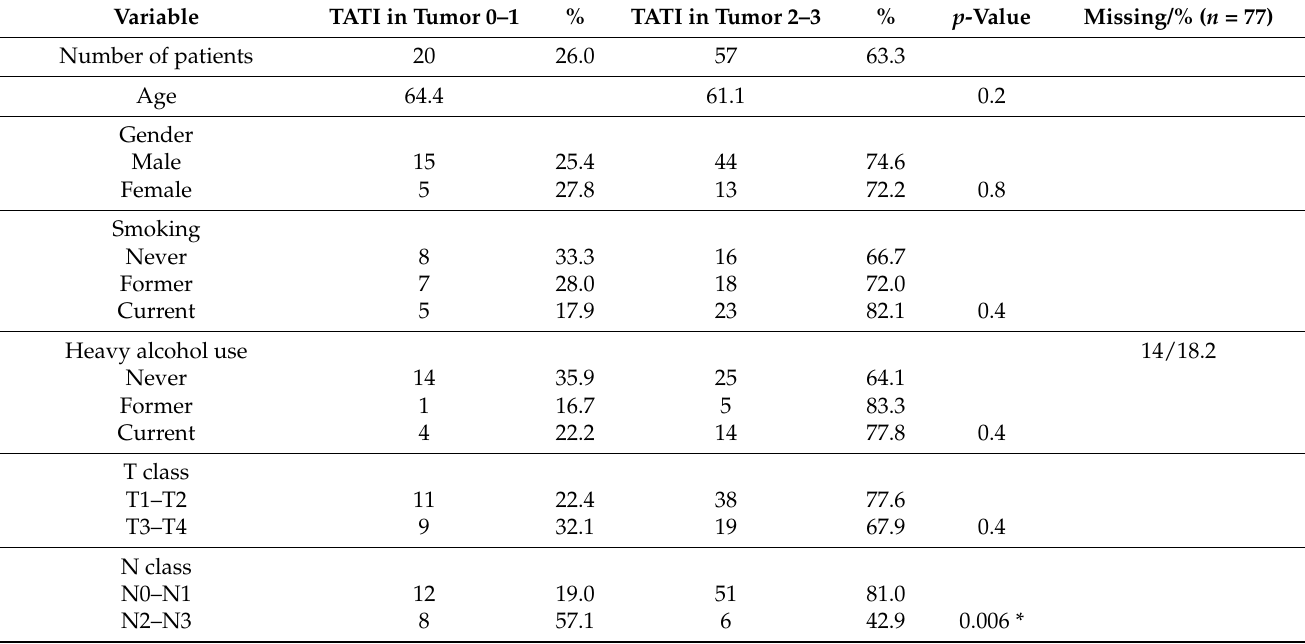
Table 3. Clinicopathological data according to TATI expression in tumor